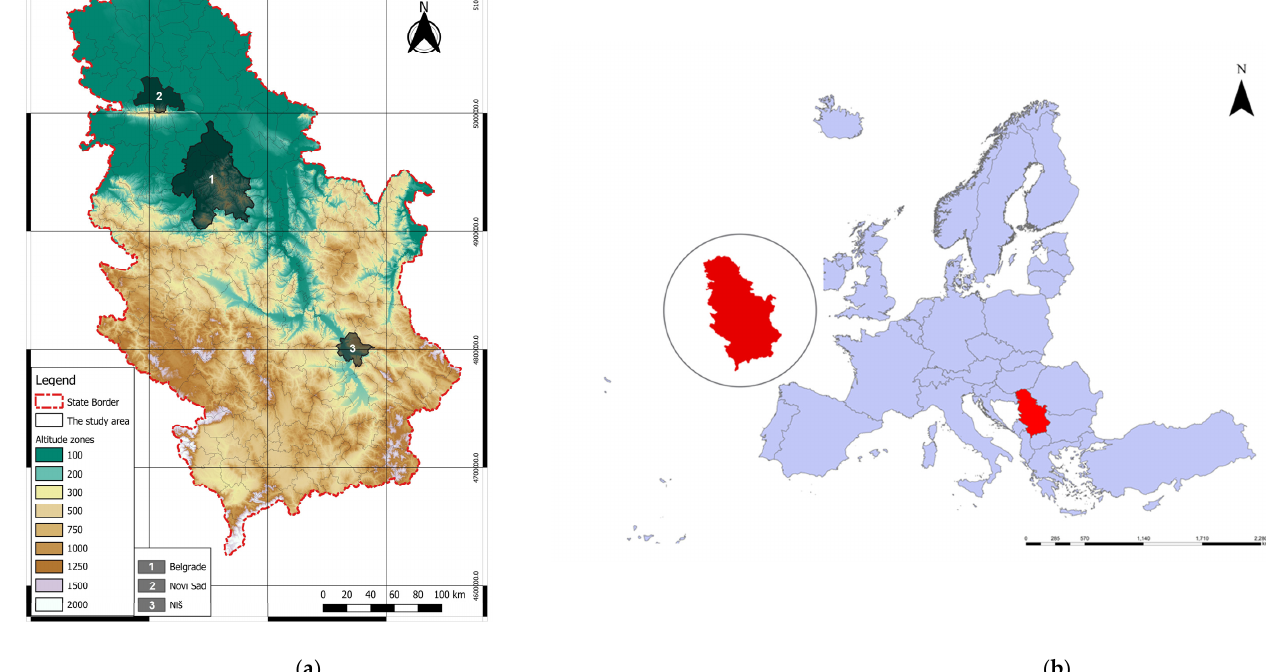
Figure 1. ( a ) Locations of the studied areas: (1) Belgrade, (2) Novi Sad and (3) Niš; ( b ) Geographical location of Serbia in Europe Figure 1a,b were created using QGIS 3.8 software by OSGeo (Beaverton, OR, USA), based on the Eurostat’ official data sets (https://ec.europa.eu/eurostat/web/gisco/geodata/reference-data/ (accessed on 21 May 2021)). Map ratio: 1:1,900,000; projection: WGS 84/UTM, Zone 34N. Altitude structure data of Serbia was obtained by classification of the Digital Elevation Model (DEM) (https://www.opendem.info/ (accessed on 22 May